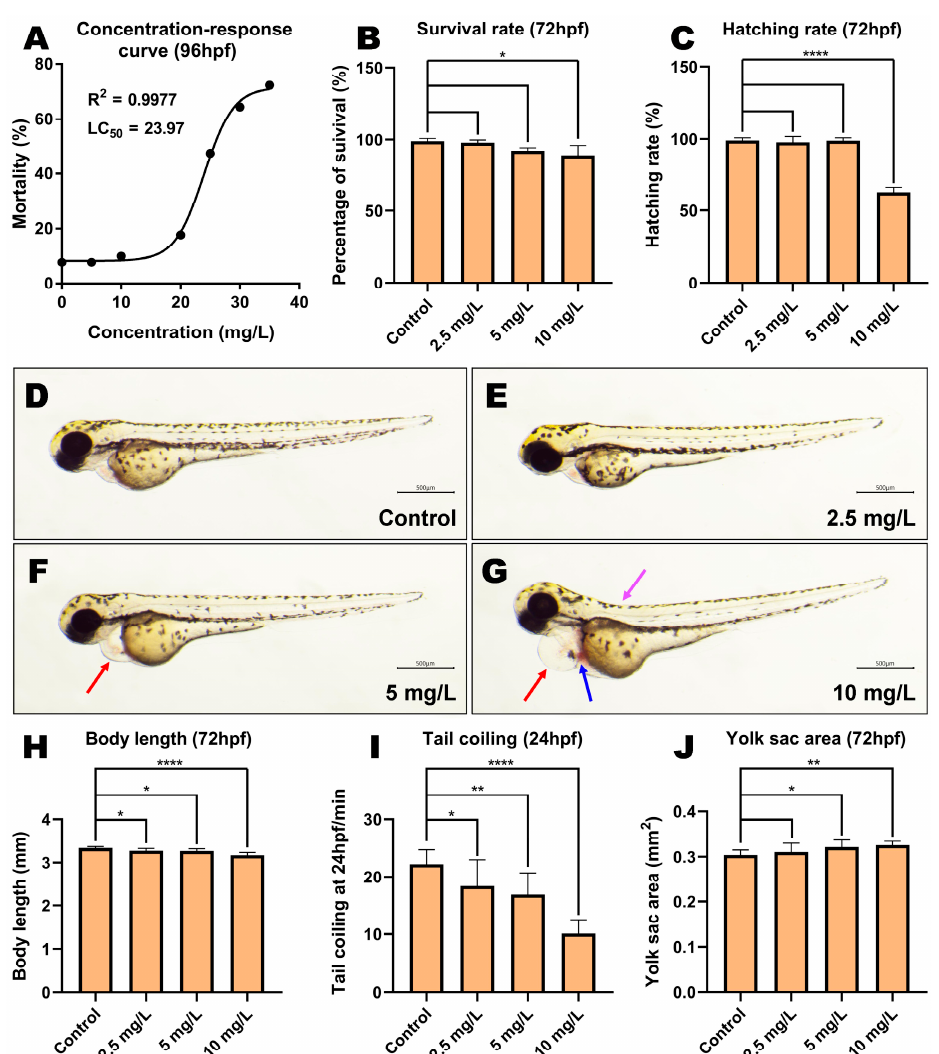
Figure 1. Developmental toxicity effects of methyl parathion exposure on zebrafish embryos. ( A ) Concentration–response curve of zebrafish embryos after MP exposure until 96 hpf. ( B ) Survival rate and ( C ) hatching rate at 72 hpf. ( D – G ) Pericardial edema was observed when zebrafish embryos were subjected to 5 and 10 mg/L MP, whereas cardiac bleeding and spinal curvature were observed when zebrafish embryos were treated with 10 mg/L. The red arrows indicate the location of the pericardial edema, the blue arrows indicate the location of the cardiac bleeding, and the purple arrows indicate the location of the spinal curvature. ( H ) Body length at 72 hpf. ( I ) Tail coiling frequency at 24 hpf. ( J ) Yolk sac area at 72 hpf. ( n = 3, mean ± SD, ANOVA, post hoc Dunnett’s multiple comparison test, * p < 0.05, ** p < 0.01, **** p < 0.0001).